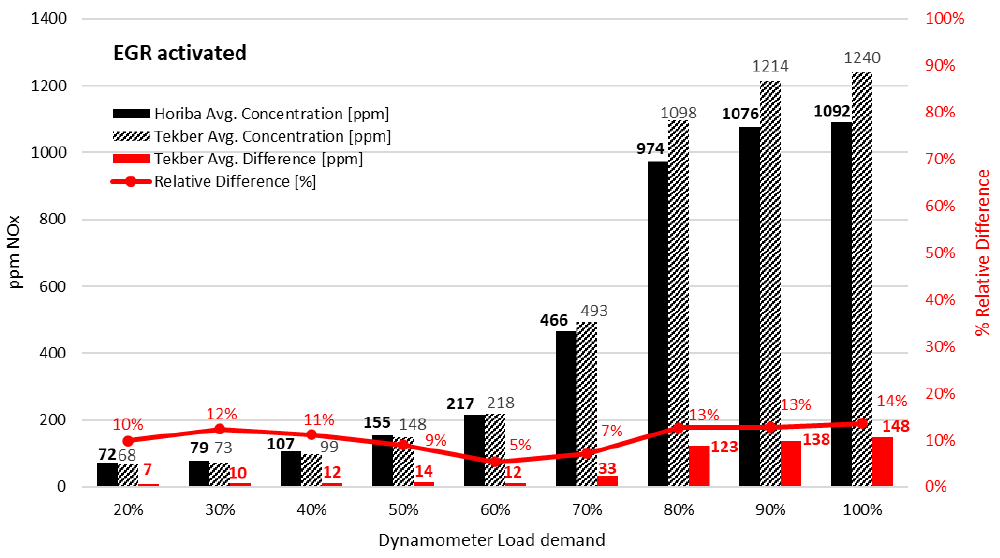
Figure 9 . Differences between Tekber and Horiba results according to the load demand with EGR.